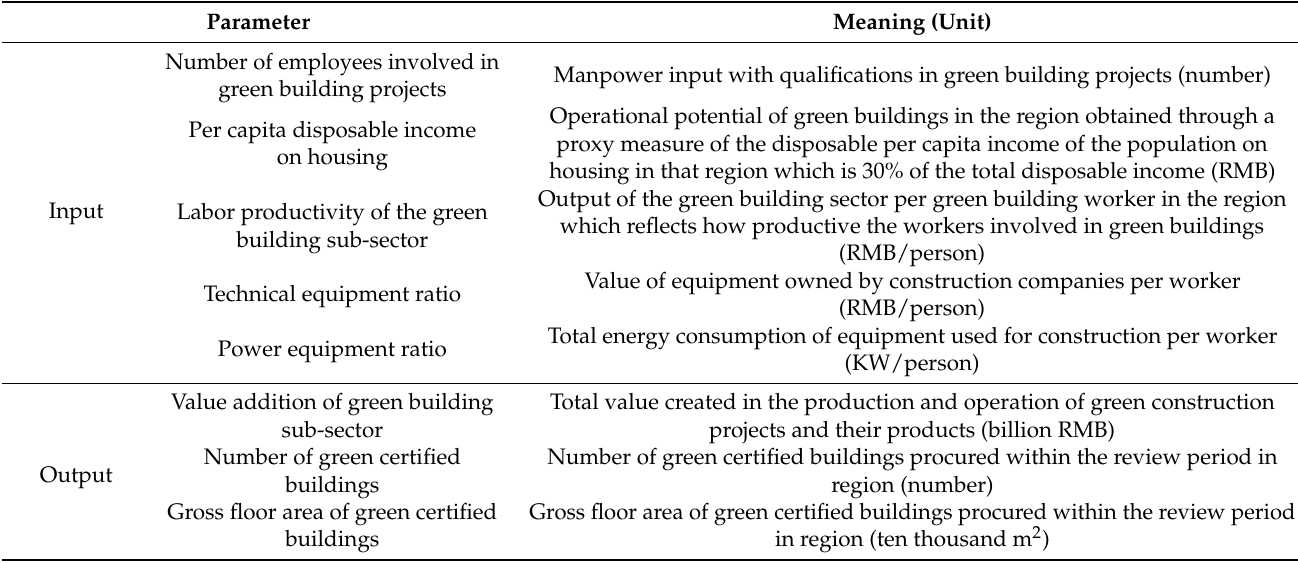
Table 1. Input and output parameters used in this study.